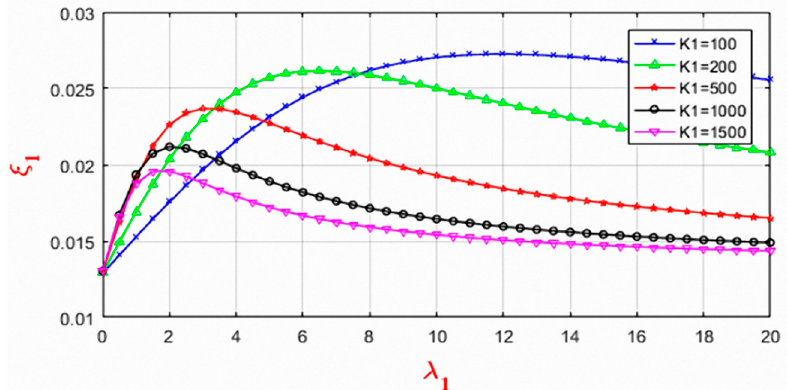
Figure 6. Relationship of ( λ 1 ; ξ 1 ) and K 1 .